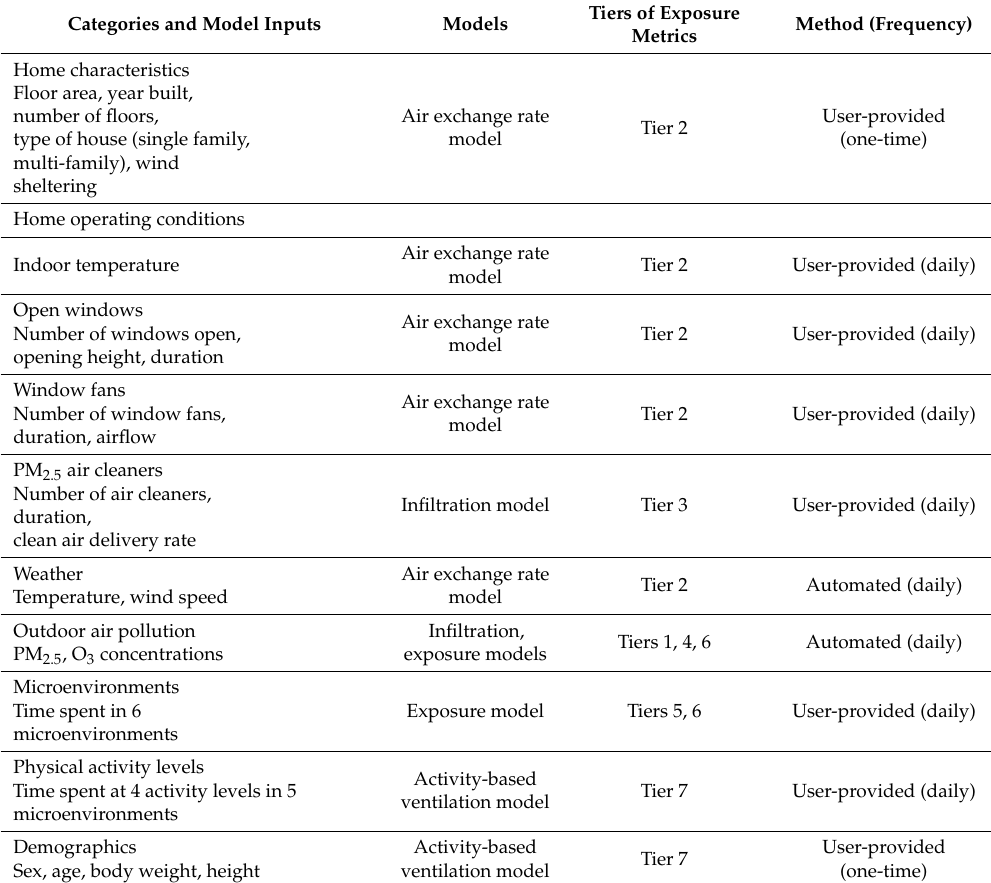
Table 1. TracMyAir